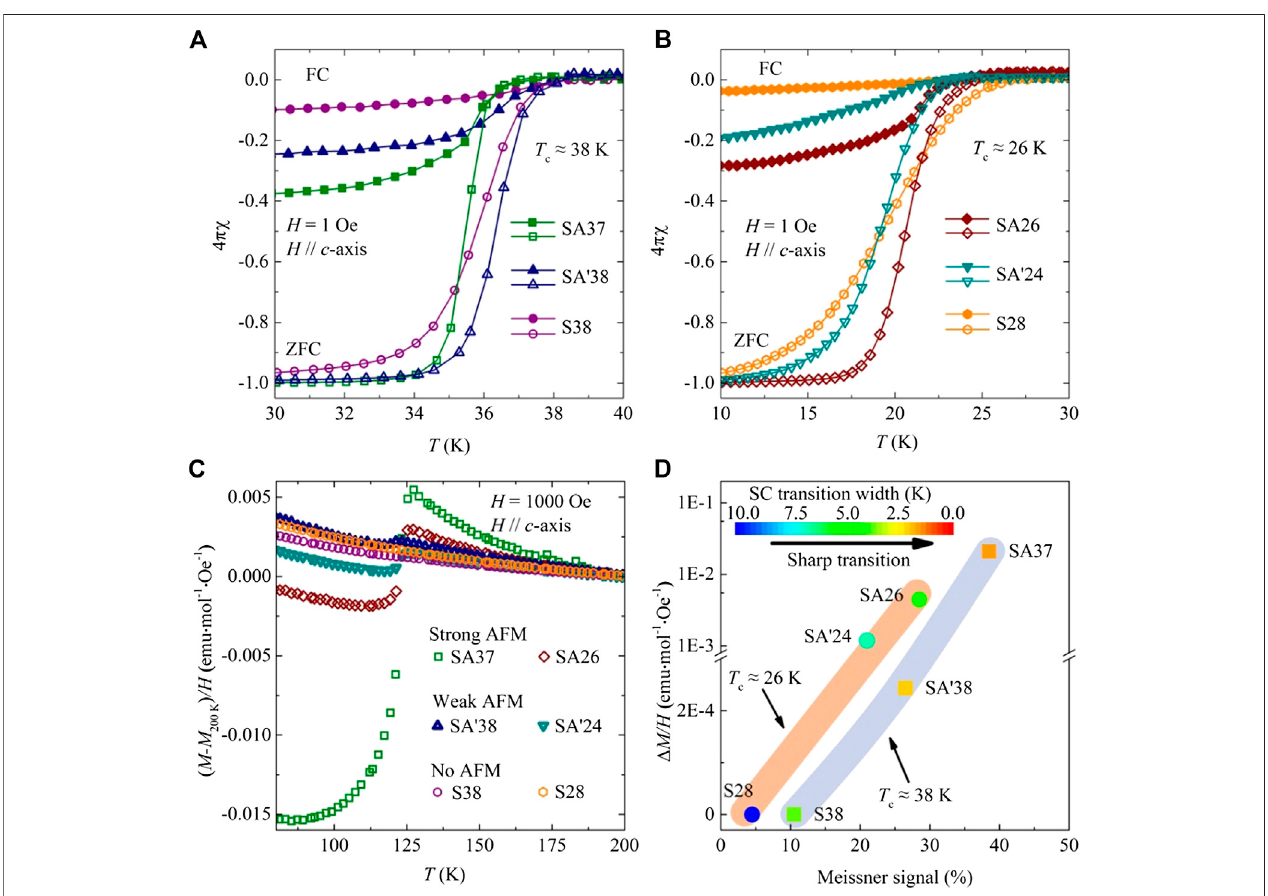
FIGURE 5 | (A,B) Temperature dependence of static magnetic susceptibility near the superconducting transitions, for the two sets of superconducting (Li,Fe) OHFeSe single crystals. (C) Antiferromagnetic (AFM) transition at ∼ 125 K is detectable for the superconducting (Tc < ∼ 38 K) samples and non-superconducting samples. (D) The corresponding AFM signal size and the SC Meissner signal size are positively correlated (60).